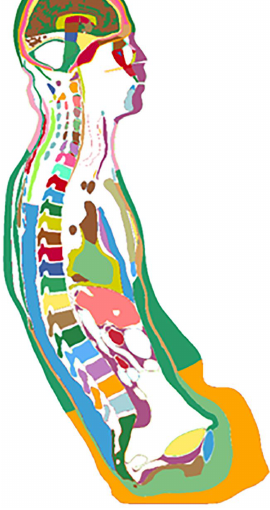
Figure 4. Sectional view of the